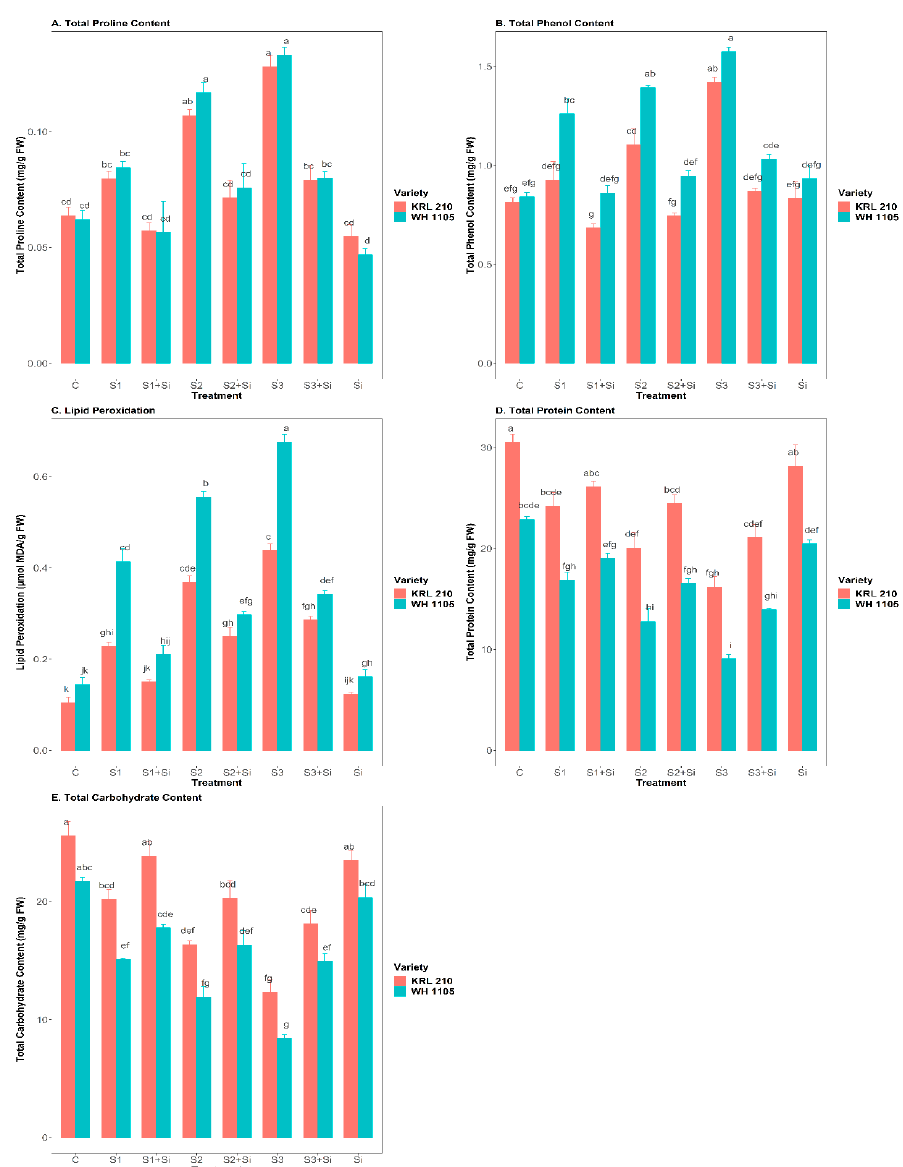
Figure 3. Effect of Si on total proline content ( A ), total phenol content ( B ), lipid peroxidation ( C ), total protein content ( D ), and total carbohydrate content ( E ) in salt-stressed wheat plants. Means ± SE; Two-way ANOVA with Tukey’s post hoc test; Each bar having different alphabets was significantly different between treatments ( p < 0.05). C: Control, S1: 40 mM NaCl stress, S2: 80 mM NaCl stress, S3: 120 mM NaCl stress, Si: 2 mM Silicon.